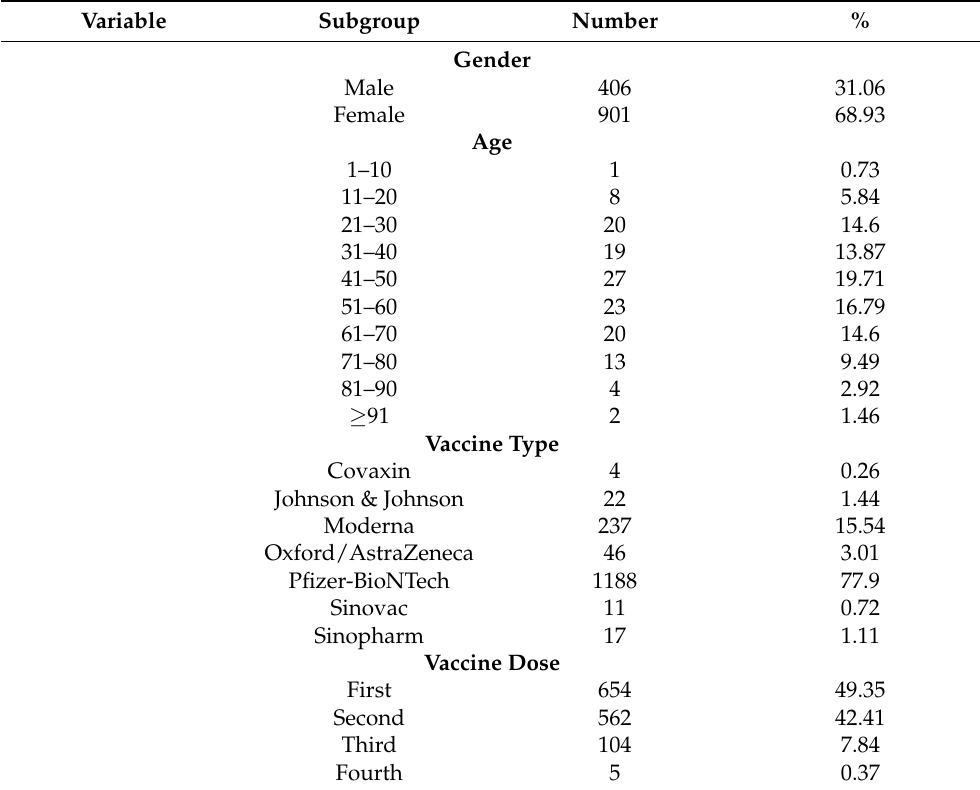
Table 2. Patients’ and COVID-19 vaccines’ characteristics.